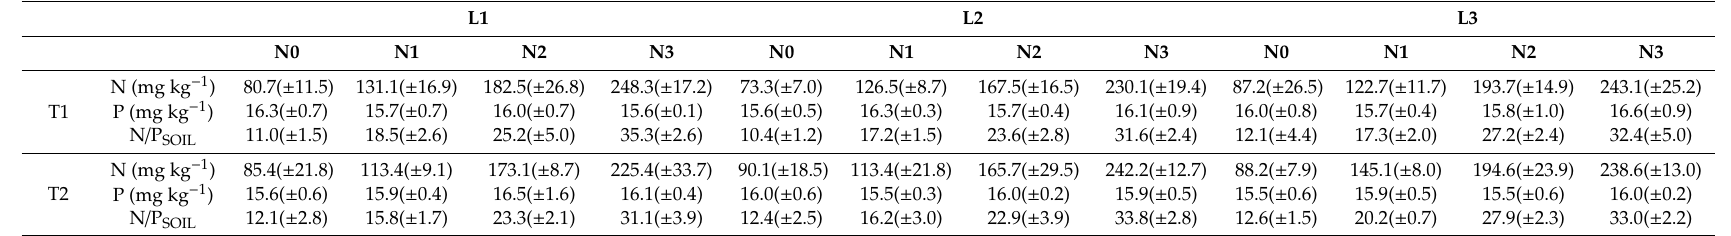
Table 4. The available N and P in soils and the molar ratio of N and P in soils (N / P SOIL